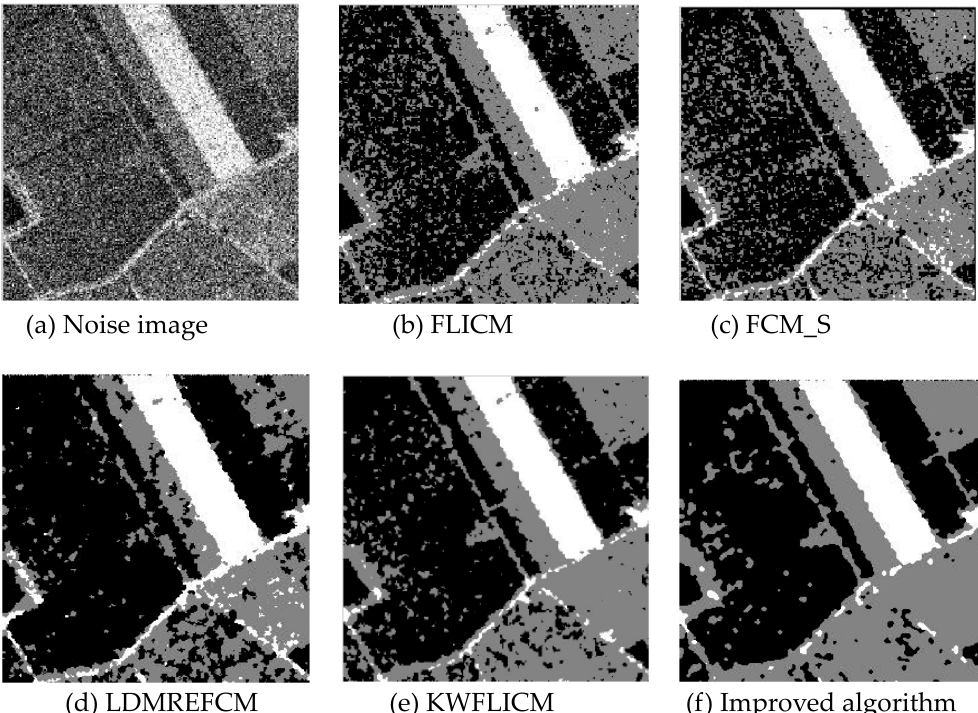
Figure 2. Gaussian noise disturbing remote sensing image 1 ( a ) and the segmentation results ( b – f ). FLICM: Fuzzy local information C-means, FCM_S: Fuzzy C-means with spatial constraints, LDMREFCM: Local data and membership relative entropy-based FCM, KWFLICM: Kernel-weighted FLICM, and Improved algorithm.